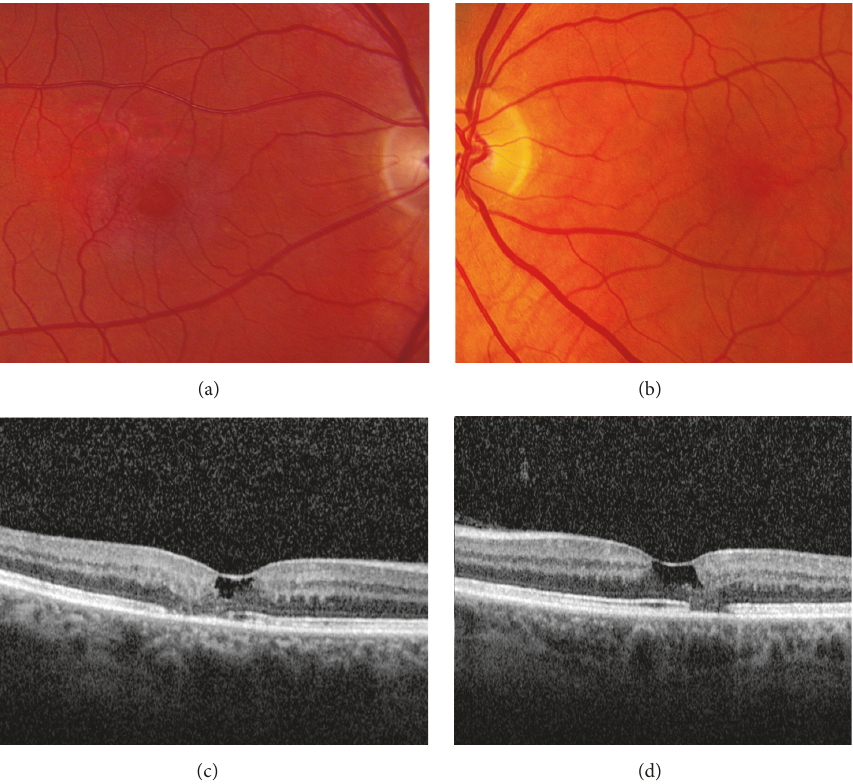
Figure 1: Macular telangiectasia type 2 initial presentation. (a) Fundus photograph of the right macula shows foveal pigment mottling and changes in the perifoveal vasculature. (b) Fundus photography of the left macula shows foveal pigment mottling. (c) Spectral domain optical coherence tomography (SDOCT) reveals an atrophic cyst and ellipsoid zone disruption in the right macula. (d) Similar SDOCT changes are present in the left